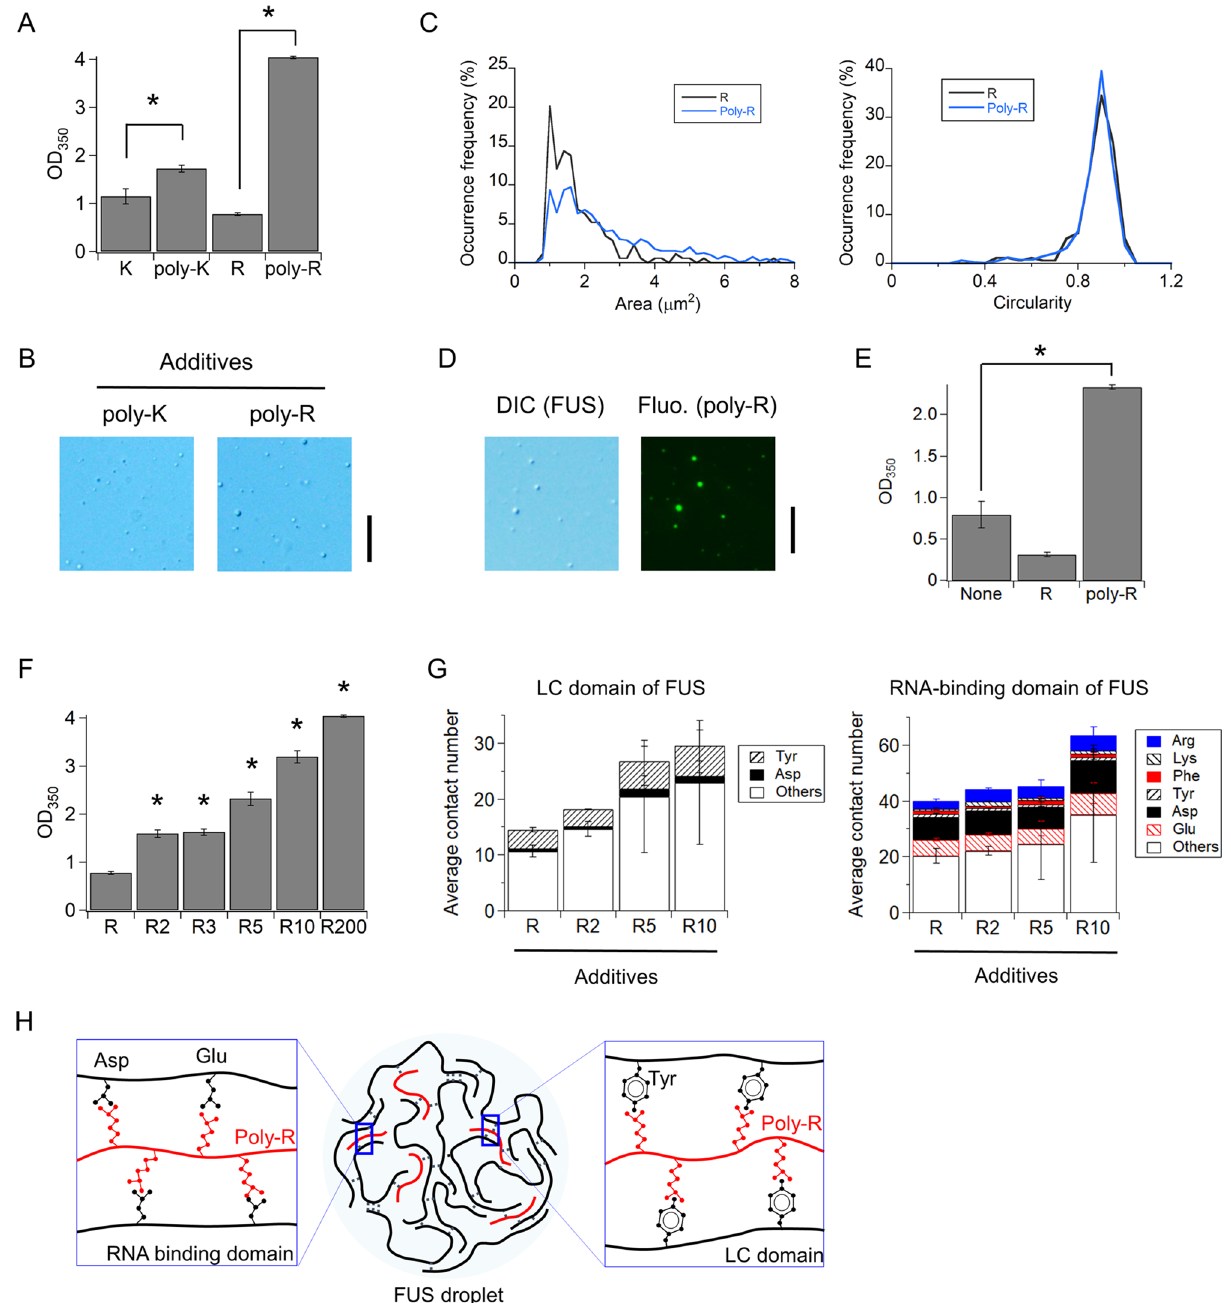
Figure 2. Polymerization of Arg and Lys promotes the formation of FUS droplets. ( A ) Effect of polymerization of Arg and Lys on MBP-FUS droplet formation detected as the scattering at 350 nm. Arg and Lys concentrations in monomer were set to 40 mM for monomers and polymers. Poly-Lys and poly-Arg are composed of 220-mer and 200-mer in median, respectively. Error bars represent the standard errors ( N = 3). Asterisks indicate a significant difference ( p = 0.045 for poly-Lys and < 0.0001 for poly-Arg (R200), two- tailed t-test). ( B ) DIC images of MBP-FUS solutions in the presence of Lys/Arg monomer and polymer. Scale bar denotes 20 µm. ( C ) Distributions of cross-section area and circularity of individual droplets of MBP-FUS in the presence of Arg monomer ( N = 177) and polymer ( N = 829). D) DIC and fluorescence microscopic images of MBP-FUS at 5 µM and Alexa488-labeled poly-R at 0.1 µM. ( E ) Effect of MBP tag removal on FUS droplet formation detected as the scattering at 350 nm in the absence of Dextran. Error bars represent the standard errors ( N = 3). Asterisk indicates a significant difference ( p = 0.01 for poly-Arg, two-tailed t-test). "None" denotes the absence of additives. F) Effect of polymer length of Arg to MBP-FUS droplet formation detected as OD 350 . Arg concentrations in monomer were set to 40 mM for monomer and polymers: 20 mM R2, 13 mM R3, and 4 mM R10. Error bars represent the standard errors ( N = 3 except for R2 and N = 6 for R2). The data for R200 was the same as that for poly-R in ( A ). Asterisks indicate a significant difference between monomer and polymers ( p < 0.0001 for R2, p = 0.019 for R3, p = 0.008 for R5, and p = 0.008 for R10; two-tailed t-test). ( G ) Molecular dynamics simulations of MBP-FUS in the presence of R, R2, R5, and R10 additives. The left and right panels show the average number of contacts between the additives and intact residues of LC- and RNA-binding domains of FUS, respectively. The colored or shaded and blank intact residues denote droplet-related residues plus Glu and others, respectively. ( H ) Schematic diagram of FUS droplets promoted by Arg polymer. Arg polymer connects intact Tyr, Asp, and Glu residues of different FUS molecules, thus promoting FUS droplets. In ( A – D , F ), the solutions contained 80 mg/mL